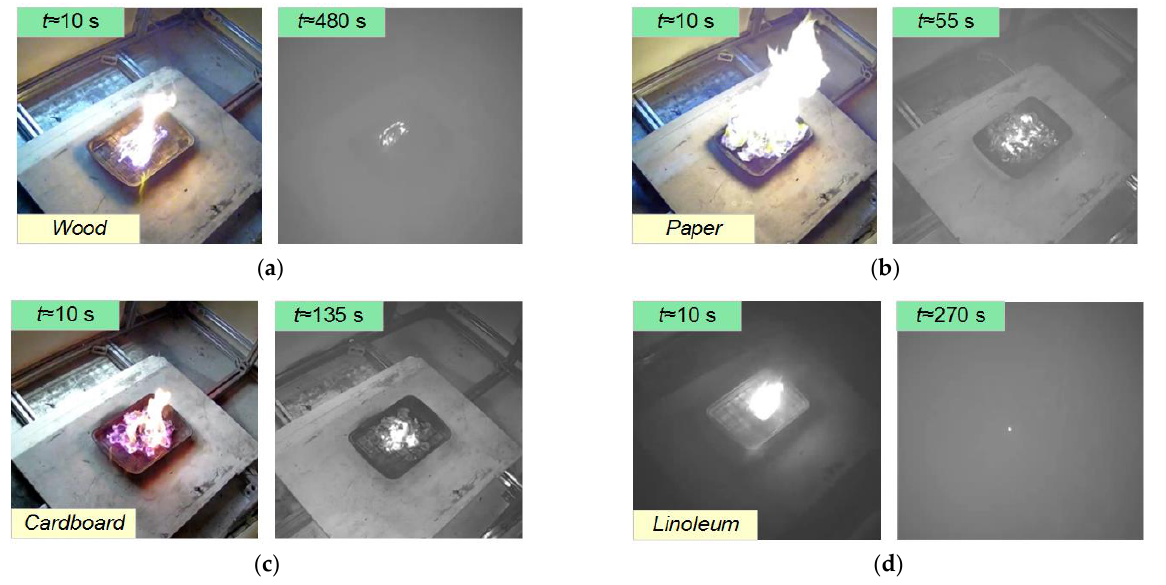
Figure 3. Images of model fire when reproducing conditions of careless handling of fire (gas burner) at the stages (from left to right) of ignition, rapid flame combustion, smoldering start and smoldering completion: ( a ) wood; ( b ) paper; ( c ) cardboard; ( d ) linoleum.